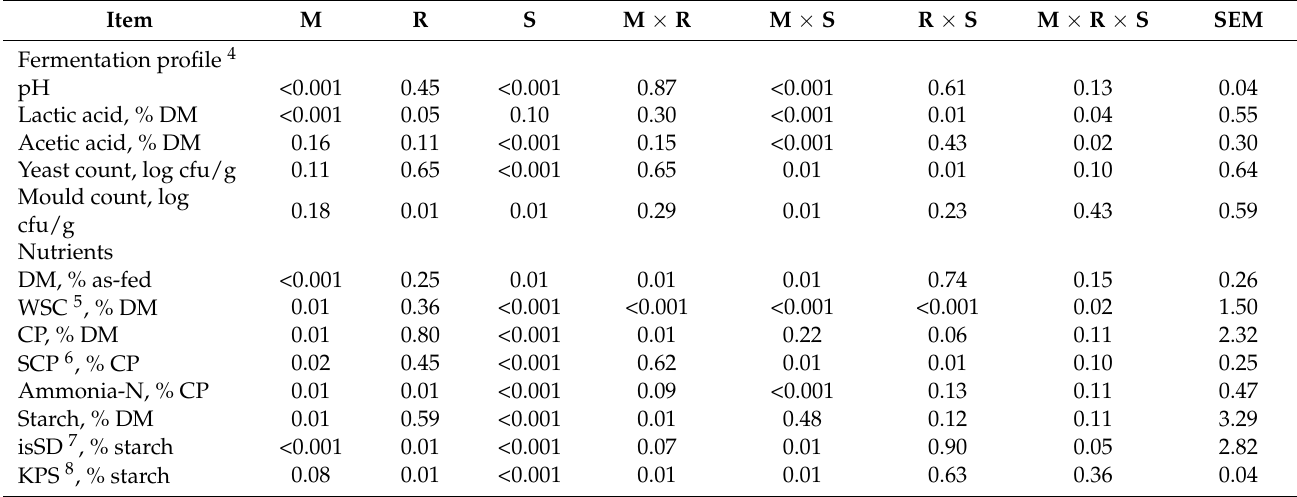
1 Whole-plant maize was harvested at 3 maturities: 1/4 (Early), 1/2 (Intermediate), and 3/4 (Late) kernel milk line. 2 Maize was processed through rolls with a gap width of either 1 or 3 mm using a self-propelled forage harvester. 3 Mini-silos were stored for either 0, 30, 120, or 240 d. 4 Propionic and butyric acids were measured but not detected. 5 WSC = water-soluble carbohydrates 6 SCP = soluble crude protein 7 isSD = 7 h ruminal in situ starch disappearance of undried, unground samples 8 KPS = kernel processing score; measured as % starch passing through a 4.75 mm sieve as described by Ferreira and Mertens